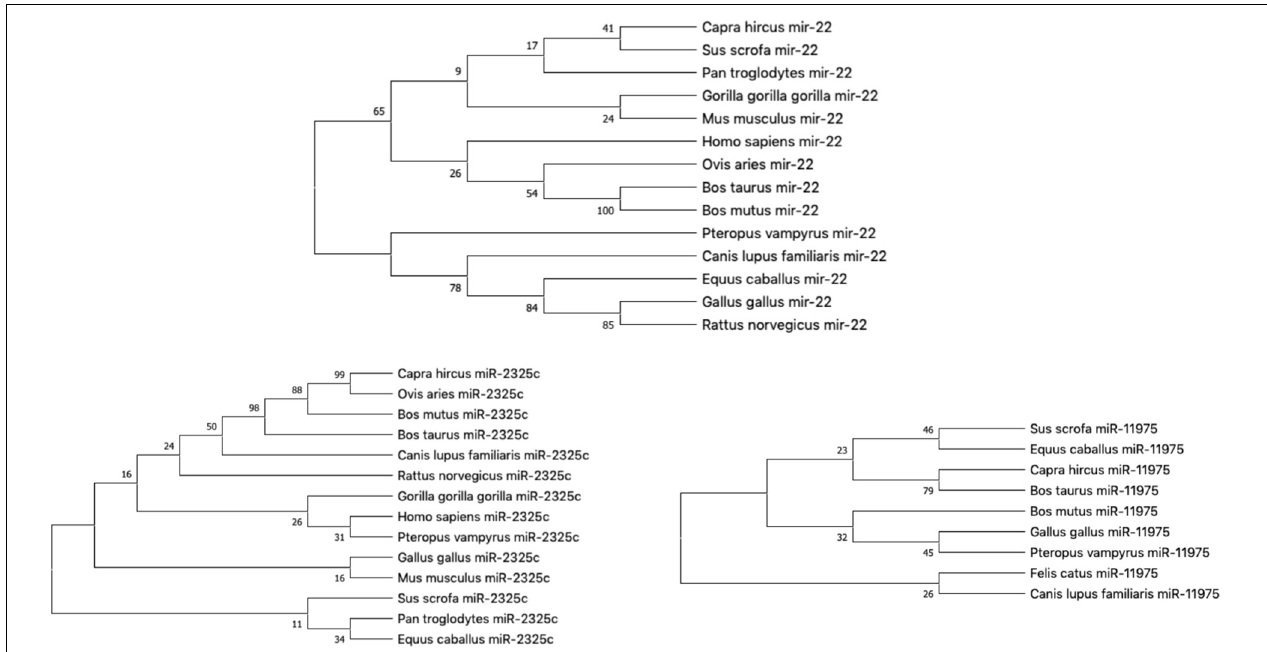
FIGURE 6 | The phylogeny of individual miRNA; (A) miRNA-22; (B) miR-2325c; (C) miR-11975 (Fewer species returned results for miR-11975 than compared to miR-22 and